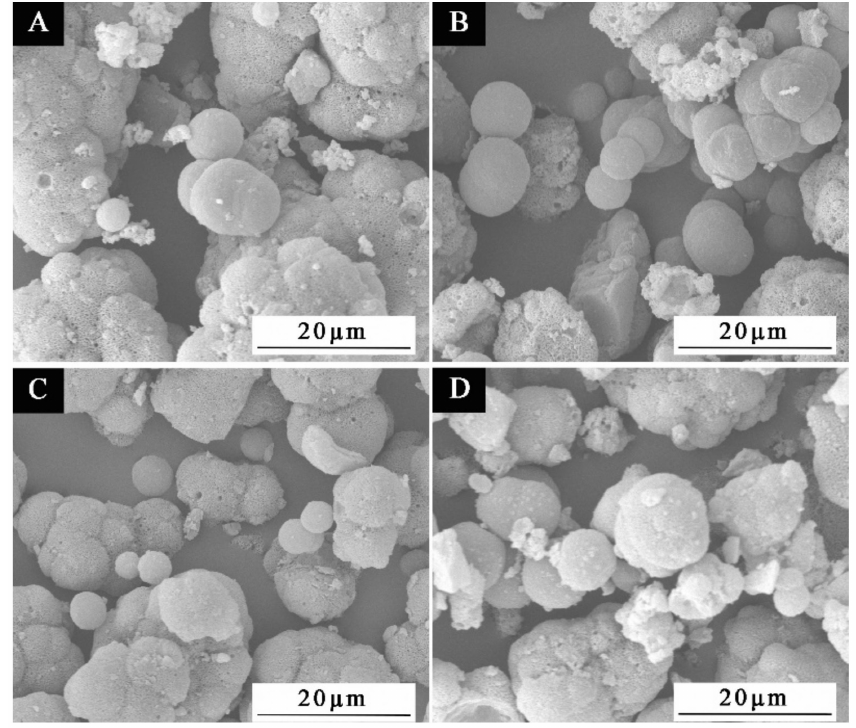
Figure 12. SEM images of microcapsules with HLB values of four emulsifiers: ( A ) 1 (cid:48) #, ( B ) 2 (cid:48) #, ( C ) 3 (cid:48) #, ( D ) 5 (cid:48) #.